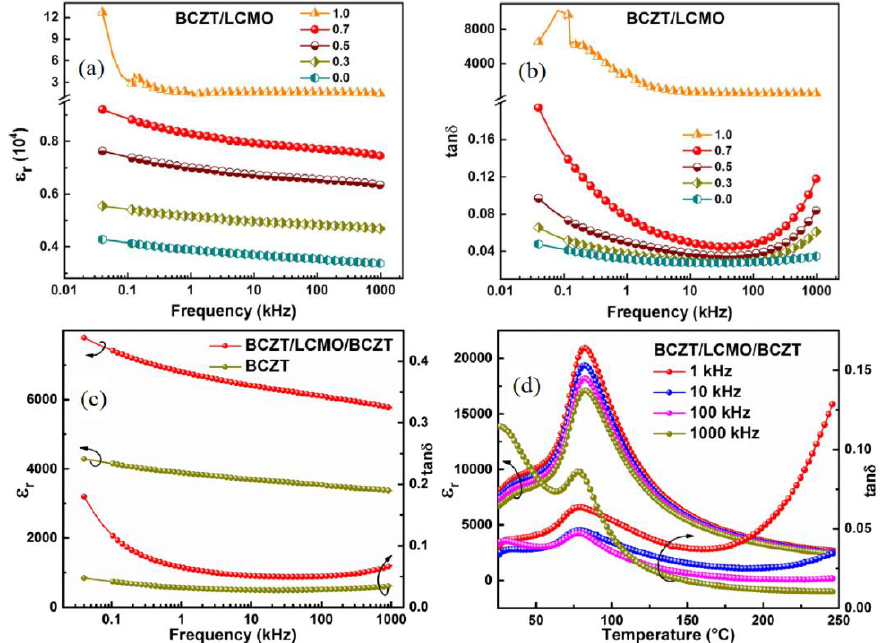
Figure 19. Room temperature frequency dependence of ε r ( a ) and tan δ ( b ) for the (1 − x)BCZT-xLCMO laminated composites and frequency ( c ) and temperature dependence ( d ) of ε r and tan δ for BCZT-LCMO-BCZT composite. Reprinted with permission from [121,122]. Copyright 2017 Elsevier and 2019 AIP Publishing.